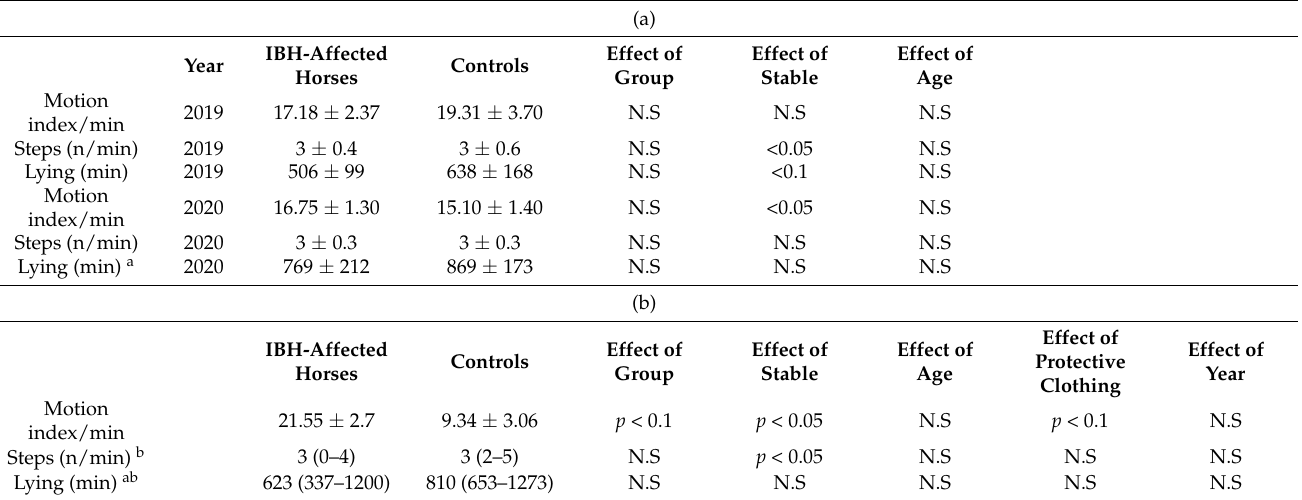
Table 4. Average movement activity (least square mean (LSM) ± standard error (SE)) measured by IceTag accelerometers (IceRobotics Ltd., Edinburgh, UK) over approximately 7 days (a) during summer 2019 (nine insect bite hypersensitivity (IBH)-affected horses and eight controls) and summer 2020 (five IBH-affected horses and four controls) and (b) for horses participating in both 2019 and 2020 (five IBH-affected horses and four